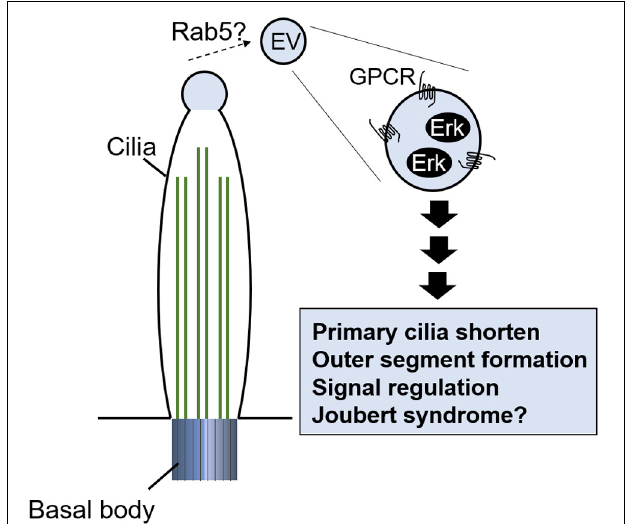
FIGURE 5 | Potential of EVs released from primary cilia tip. EVs contain signal molecules including G protein–coupled receptor (GPCR) and Erk. Release of EVs regulates primary cilia length, outer segment formation in photoreceptor cells, and signal transduction.